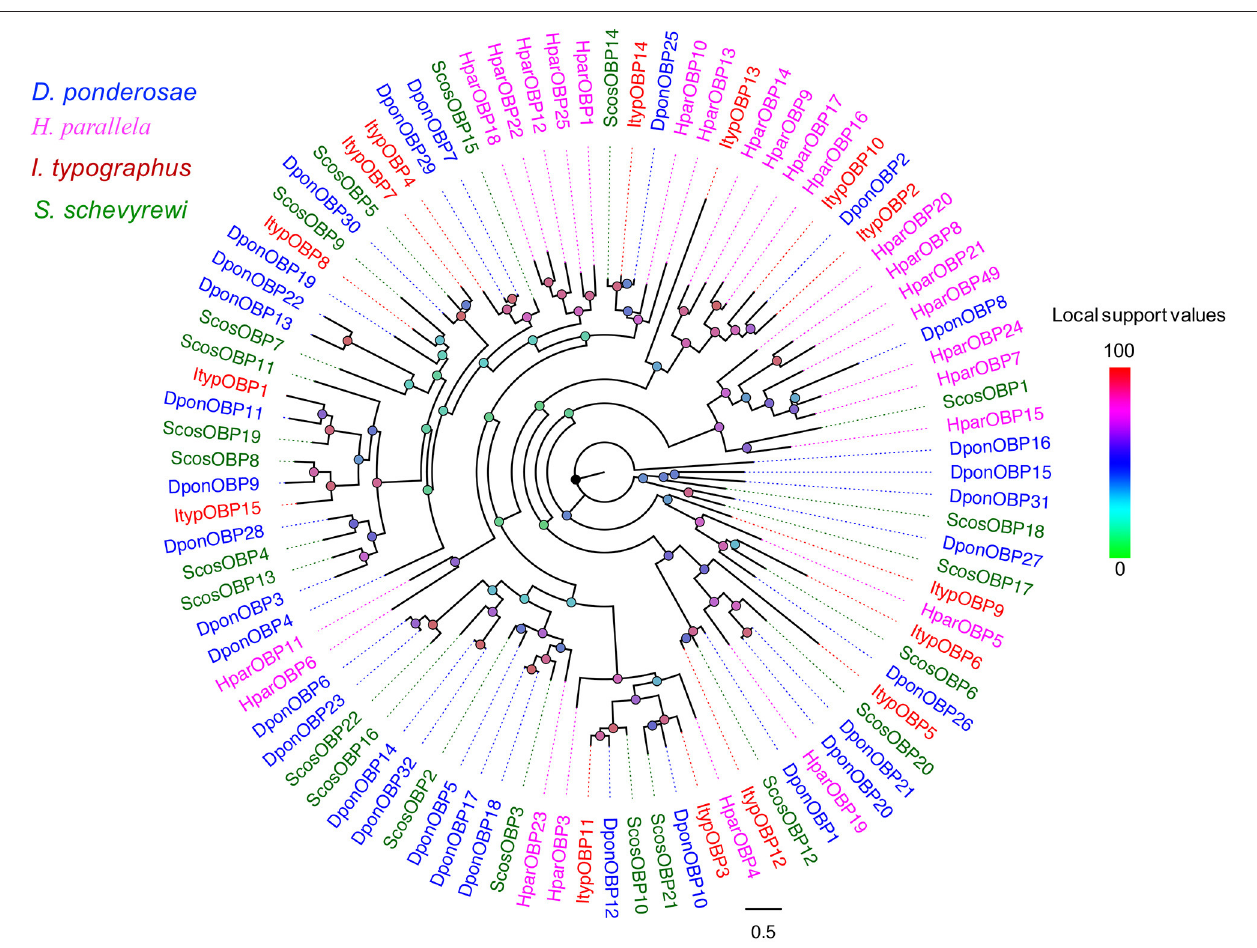
FIGURE 4 | Phylogenetic tree of candidate ScosOBPs with known Coleoptera odorant-binding proteins sequences. Tcas, T. castaneum ; Dpon, D. ponderosae ; Hpar, H. parallela ; Ityp, I. typographus ; Scos, S. schevyrewi